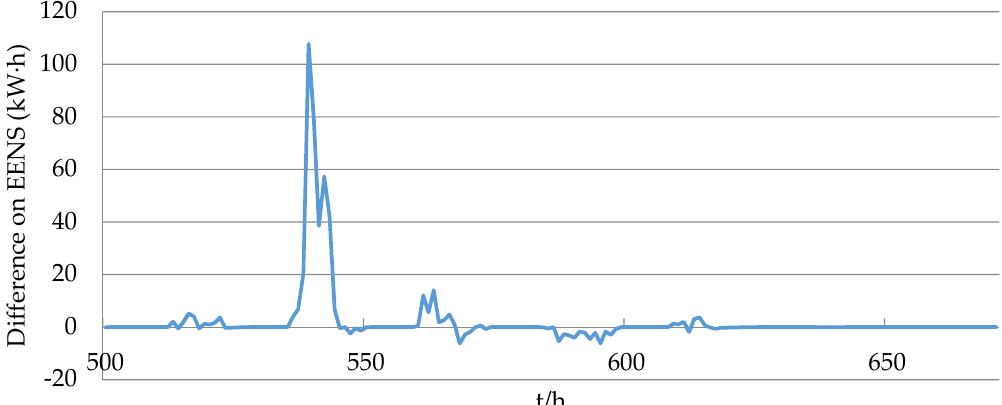
Figure 3. Difference on expected energy not supplied (EENS) whether correlation is considered.